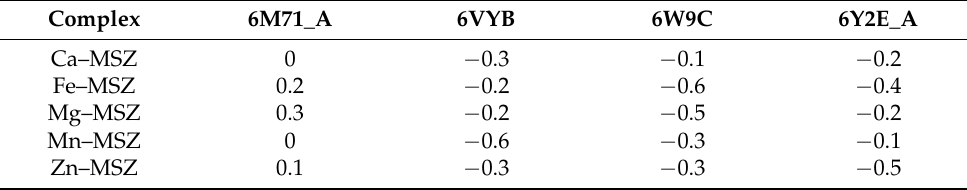
Table 2. Binding energy changes with respect to Methisazone complexation (kcal/mol). Complex 6M71_A